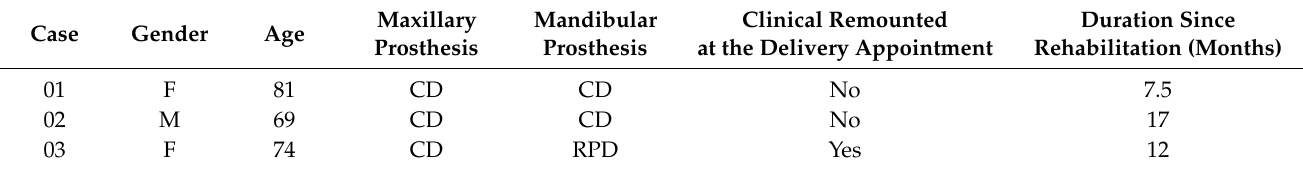
Table 1. General characteristics of analyzed cases. CD: complete denture. RPD: removable partial